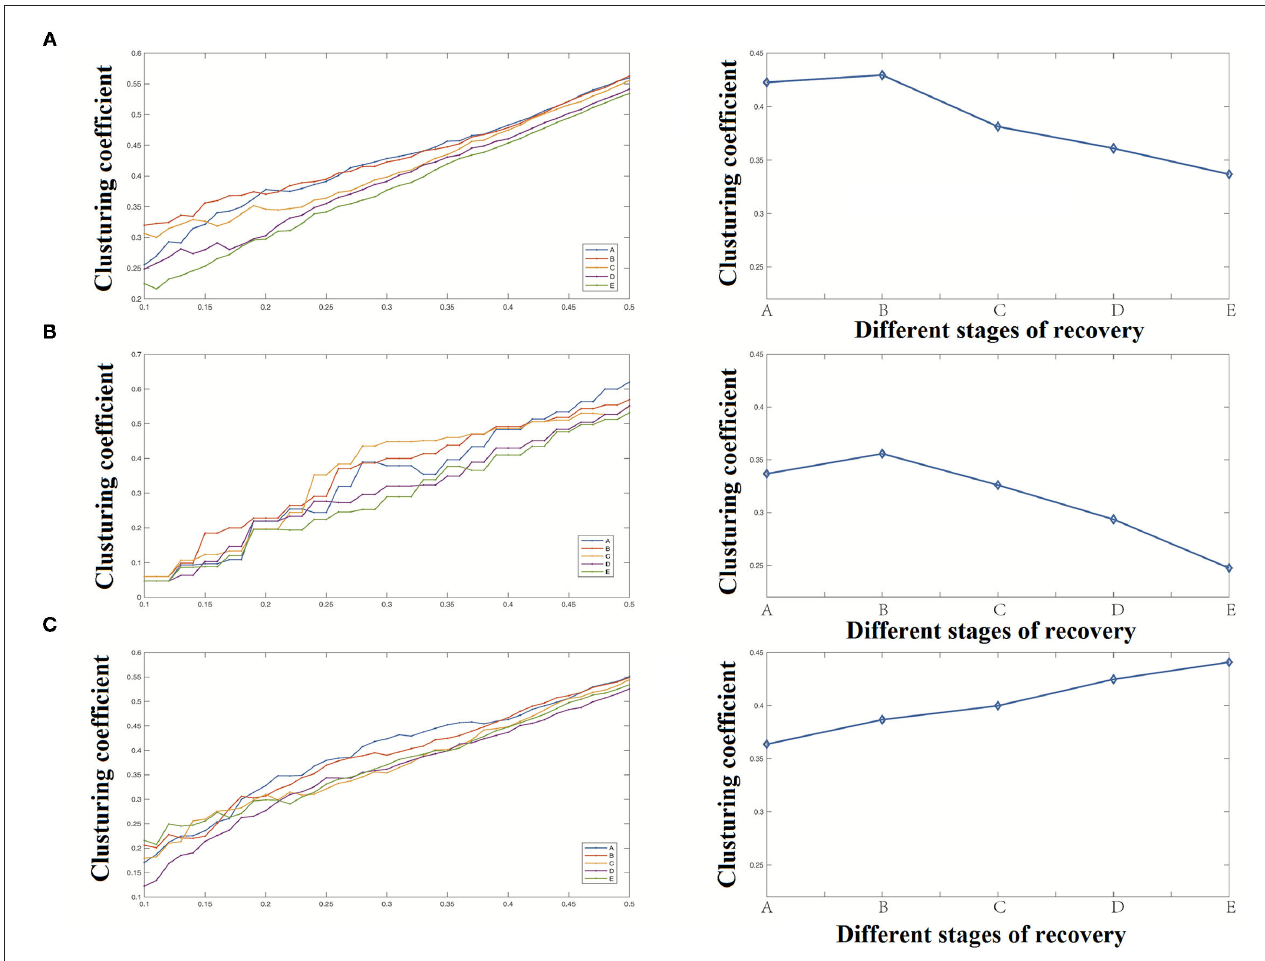
FIGURE 6 | Clustering coefficient analysis results [ (A) clustering coefficient of the whole network, (B) clustering coefficient of the cortical region, (C) clustering coefficient of the deep